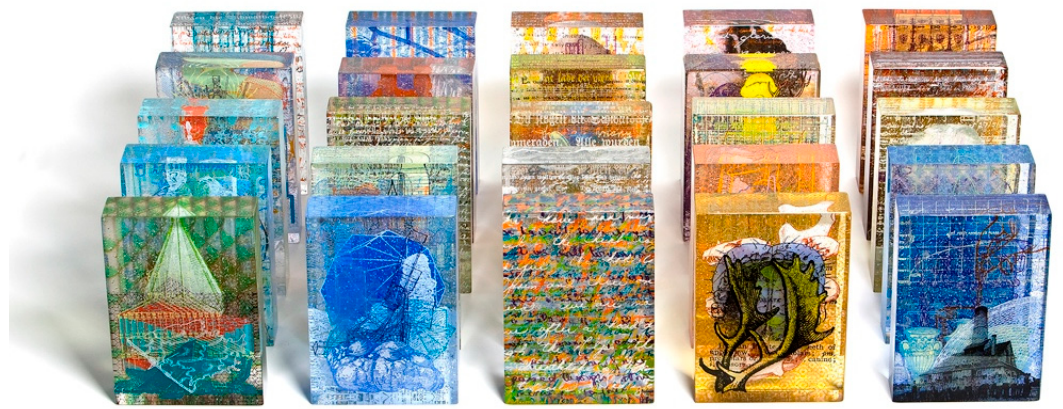
Figure 1. Jeffrey Sarmiento, Encyclopaedia ( Volumes ), 2012. Screenprinted, fused and polished glass. Photo: David Williams.